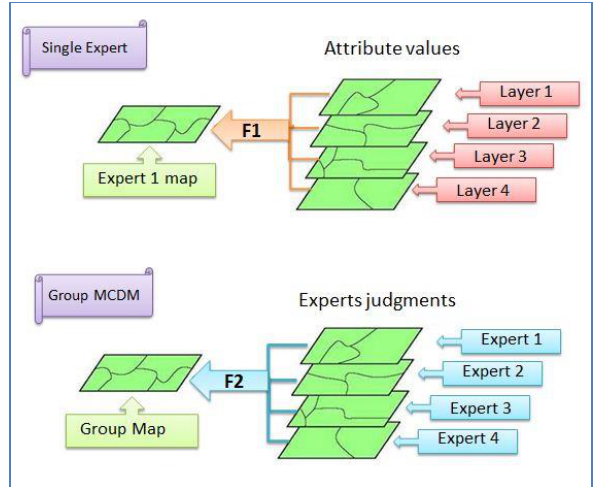
Figure 1. Group decision